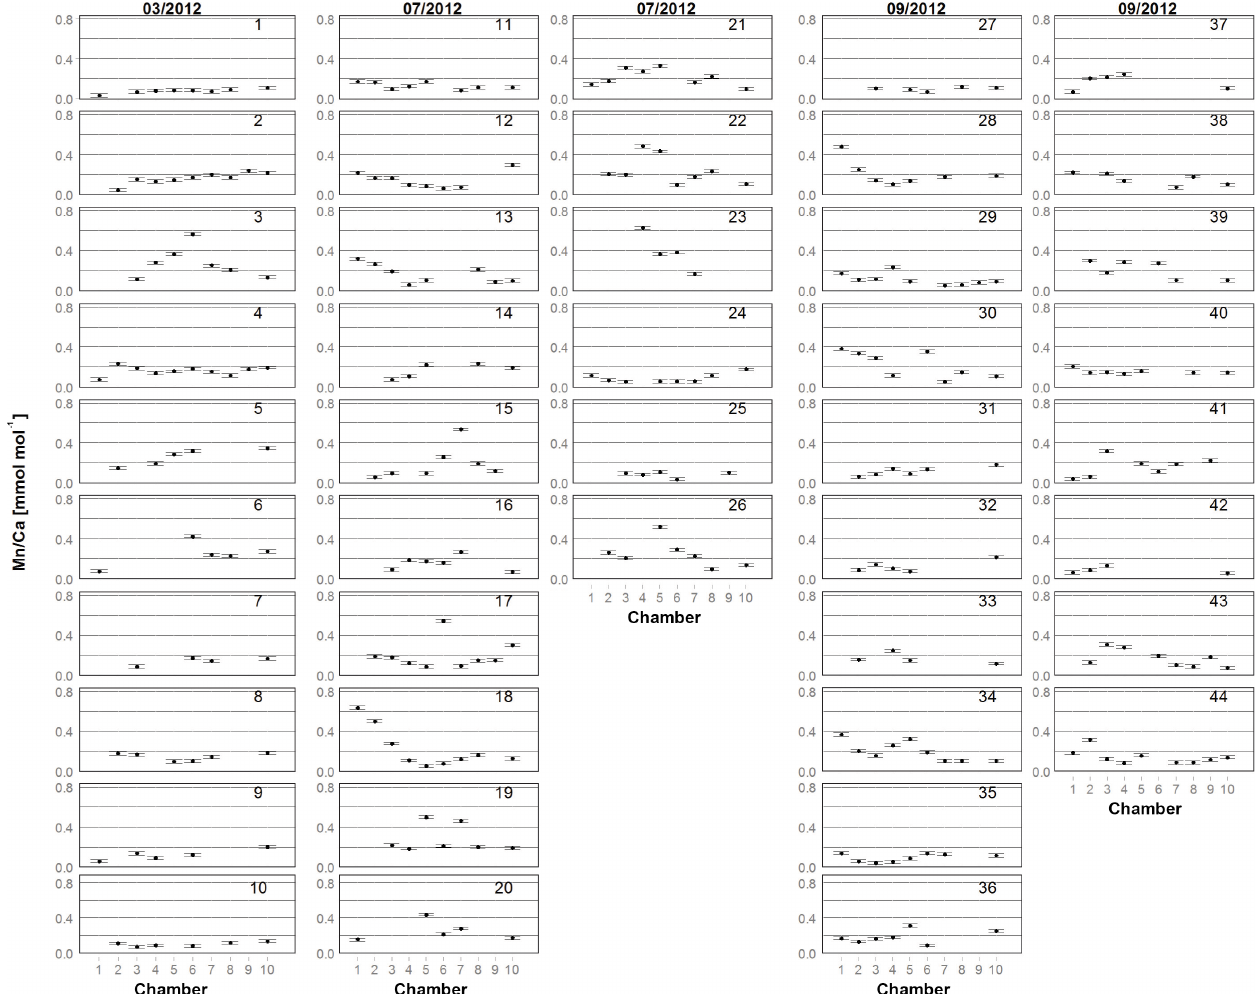
Figure 2. Mn / Ca for each chamber in living specimens of A. tepida from Lake Grevelingen, collected in March (03/2012), July (07/2012) and September (09/2012) 2012 (specimens labelled from 1 to 44 as in Table A1). One plot represents one specimen. Numbers on x axis indicate chambers: 1 – penultimate chamber; 2 – antepenultimate chamber, etc.; 10 – central part of test. Error bars represent the Mn / Ca SD of multiple analyses of the foraminiferal carbonate standard NFHS (see Sect. 2.3 and